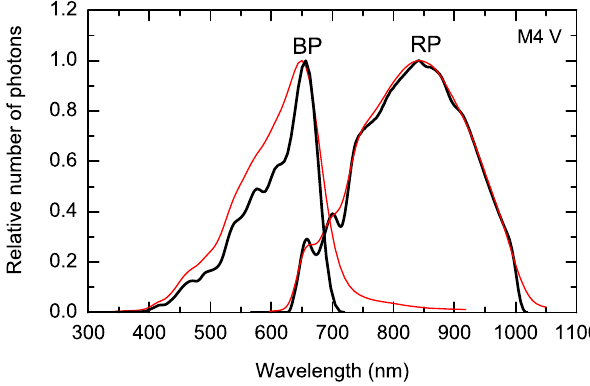
Fig. 7. The same as in Figure 1 but for M4 V type